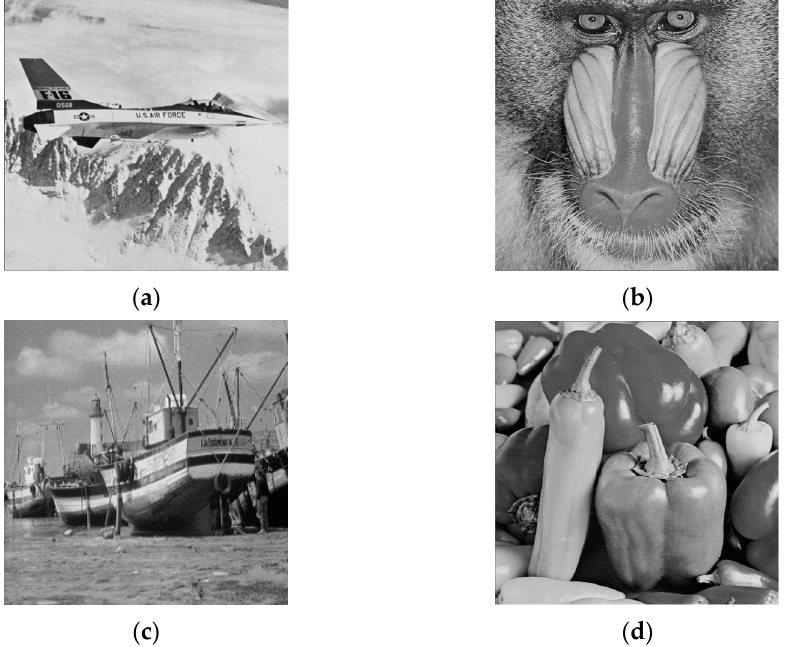
Figure 7. Test images. ( a ) Airplane; ( b ) Baboon; ( c ) Boat; ( d ) Peppers.